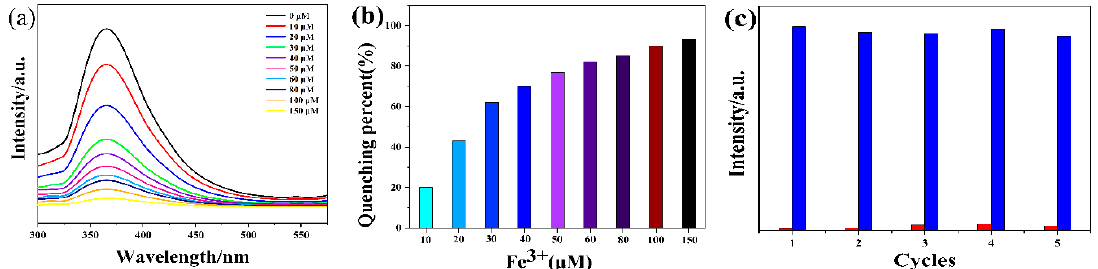
Figure 5. ( a ) The luminescence quenching exhibition of the complex dispersed in metal cations (the solution with a concentration: 1.0 mmol·L − 1 ). ( b ) The luminescence quenching of the complex dispersed in organic small molecules. ( c ) Comparison of the luminescence intensity of the complex along with the mixed metal ions.